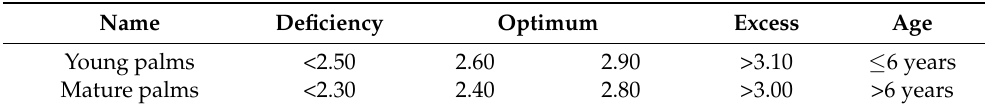
Table 1. Nutrient concentration of nitrogen (%) in leaf 17 is associated with deficiency, optimum, and excess in young and mature palms [34].